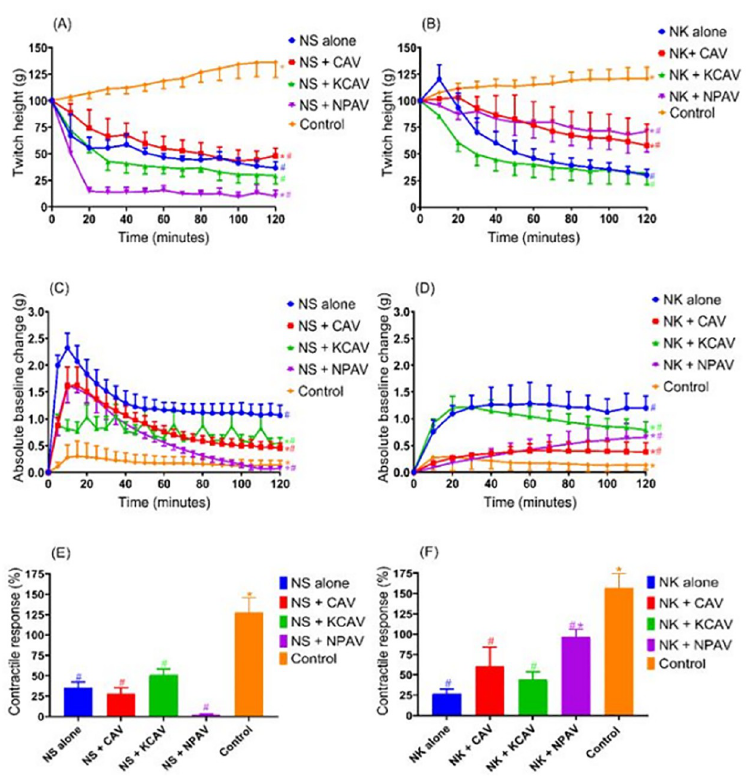
Fig 8. Effect of pre-incubation with antivenom on directly stimulated twitches of tissues and exposed to Malaysian N . sumatrana and N . kaouthia . Panel (A) N . sumatrana venom (10 μ g/mL) and (B) N . kaouthia venom (10 μ g/mL) indicate change of direct twitch height in tissues with prior addition of recommended titer of Cobra Antivenom (CAV), Neuro Polyvalent Antivenom (NPAV) and King Cobra Antivenom (KCAV). Panel (C) N . sumatrana venom and (D) N . kaouthia venom indicate absolute baseline change of tissues with prior antivenom addition and exposure to venom while on direct simulation. Panel (E) N . sumatrana venom and (F) N . kaouthia venom indicate change in contractile responses to exogenous KCl in tissue with prior addition of recommended titer Cobra Antivenom (CAV), Neuro Polyvalent Antivenom (NPAV) and King Cobra Antivenom (KCAV). NS indicates N . sumatrana venom and NK indicates N . kaouthia venom. � p < 0.05, significantly different than the respective venom alone and # p < 0.05, significantly different than control (distilled water) (n = 3, one-way